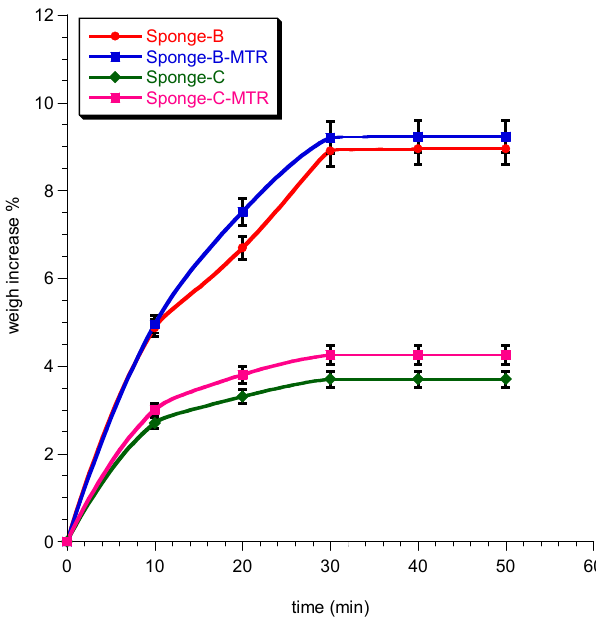
Figure 2. Percent of weight increase of sponges maintained in environmental moisture over time. Data represent mean ± SE ( n = 3).